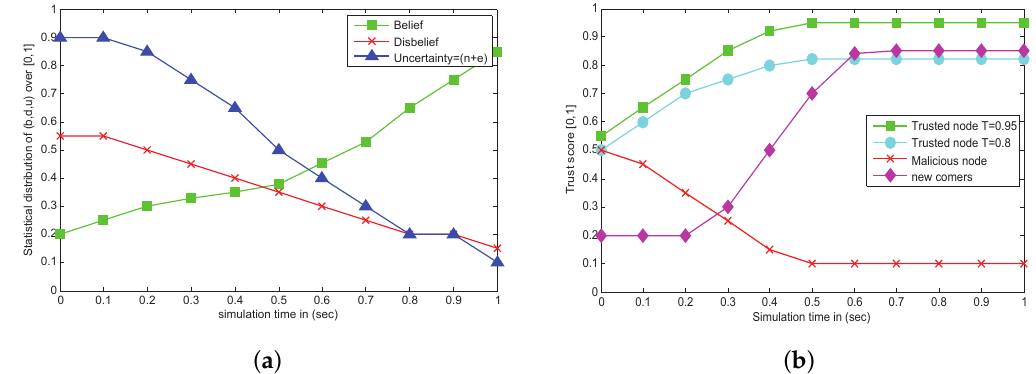
Figure 7. ( a ) Simulated analysis of belief, disbelief and uncertainty at network start. ( b ) Simulated behavior of trusted, malicious and new comers After some